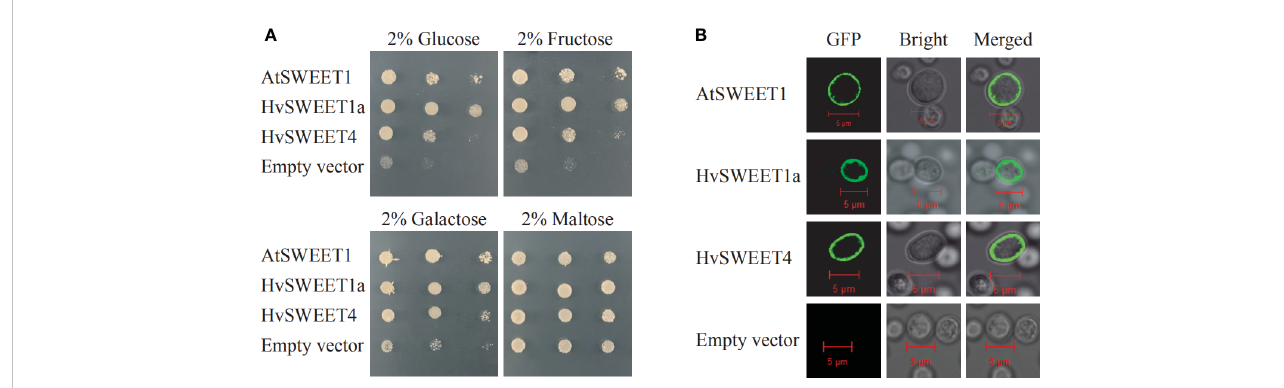
FIGURE 6 HvSWEET1a and HvSWEET4 have transport activity of hexoses. (A) Complementation of hexose uptake-de fi ciency of the yeast mutant EYB.VW 4000. Glucose, Galactose, Fructose and Maltose denote the corresponding carbon source used in the media. Photographs were taken 3 days after incubation. Experiment was repeated three times with similar results. AtSWEET1, positive control; Empty vector, negative control. (B) Plasma membrane subcellular localizations of HvSWEET1a, HvSWEET4 and AtSWEET1 in yeast cells. Bars = 5 m